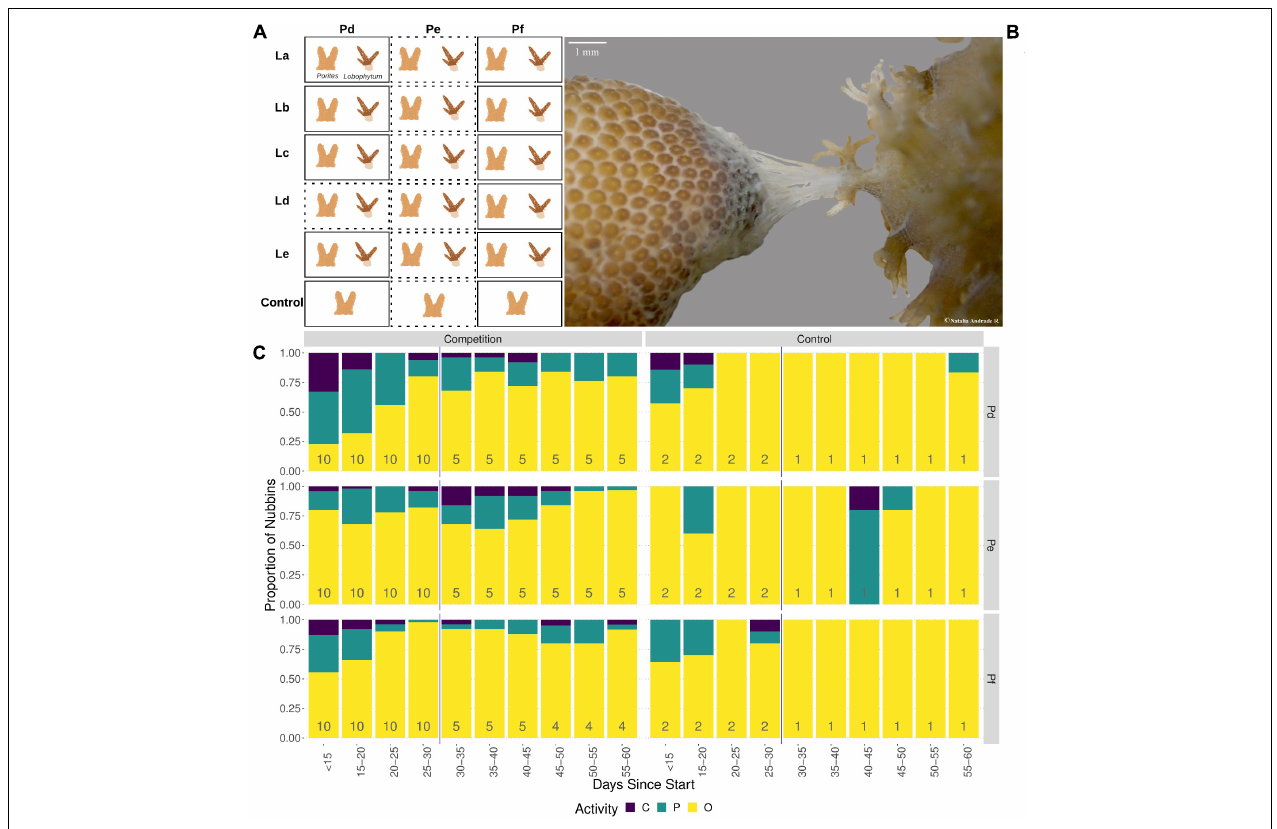
FIGURE 1 | Behaviour of Porites in the presence of Lobophytum . (A) Experimental design showing pairing of three competing Porites colonies (columns) with the five Lobophytum (rows). Dotted rectangles indicate samples not included in differential expression analysis; (B) Photograph (OLYMPUS TG-3, focal length 18 mm) showing Porites Pf (right) attacking Lobophytum (left) with mesenteric filaments at interaction day 50. (C) Barplot showing variation in polyp activity over time. Each bar shows relative counts of nubbins in each of the three activity states: black representing closed polyps, green partially open and yellow open polyps. Total numbers of nubbins contributing to each bar are shown at its base. The activity state represented per nubbin corresponds to the average of the three polyp activities observed per day. Reduction of number of the nubbins after day 30 corresponds to sampling time point of a technical replicate of each genotypic